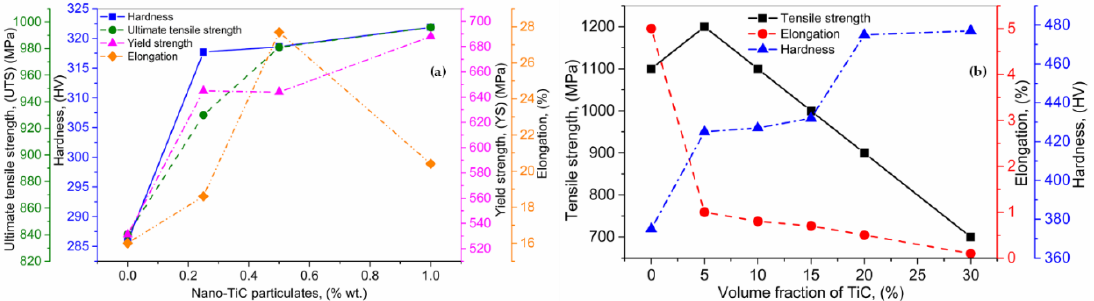
Figure 10. ( a ) Influence of Nano-TiC particulates on the hardness, ultimate tensile strength, yield strength, and elongation, and ( b ) the consequence of TiC (vol.%) on Tensile strength, elongation, and hardness; based on the data provided in Ref. [56,142].